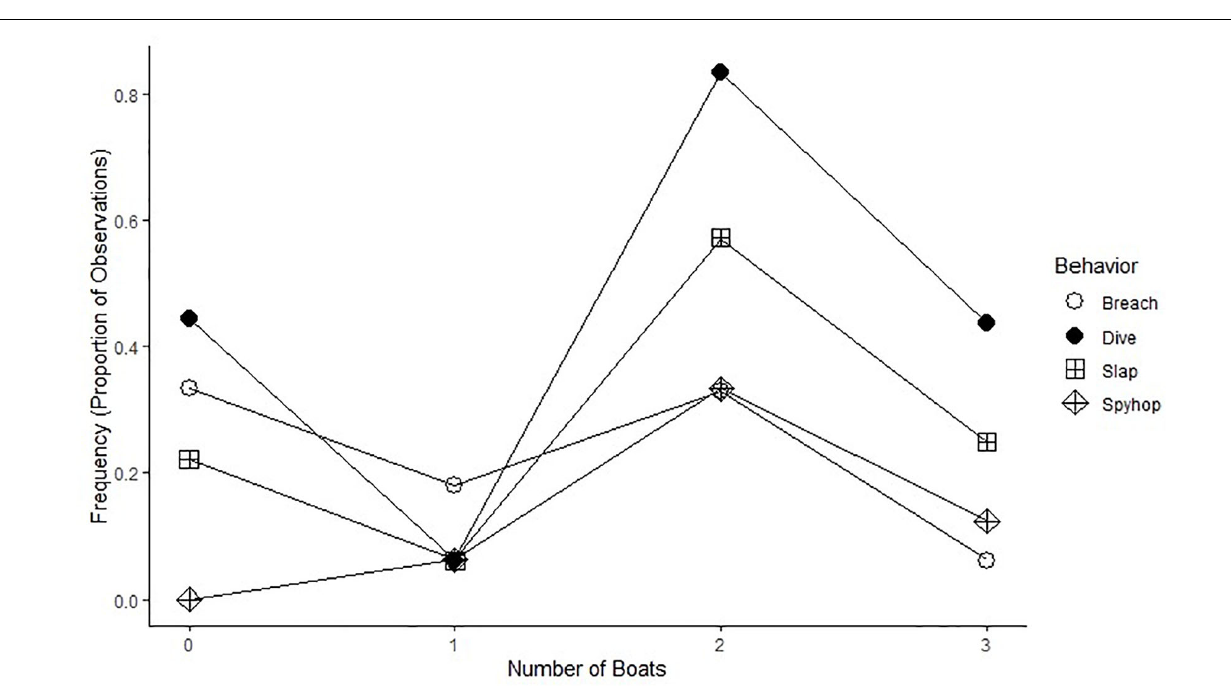
FIGURE 3 | The frequency of behavioral observations as a proportion of the total numbers of observations for each boat